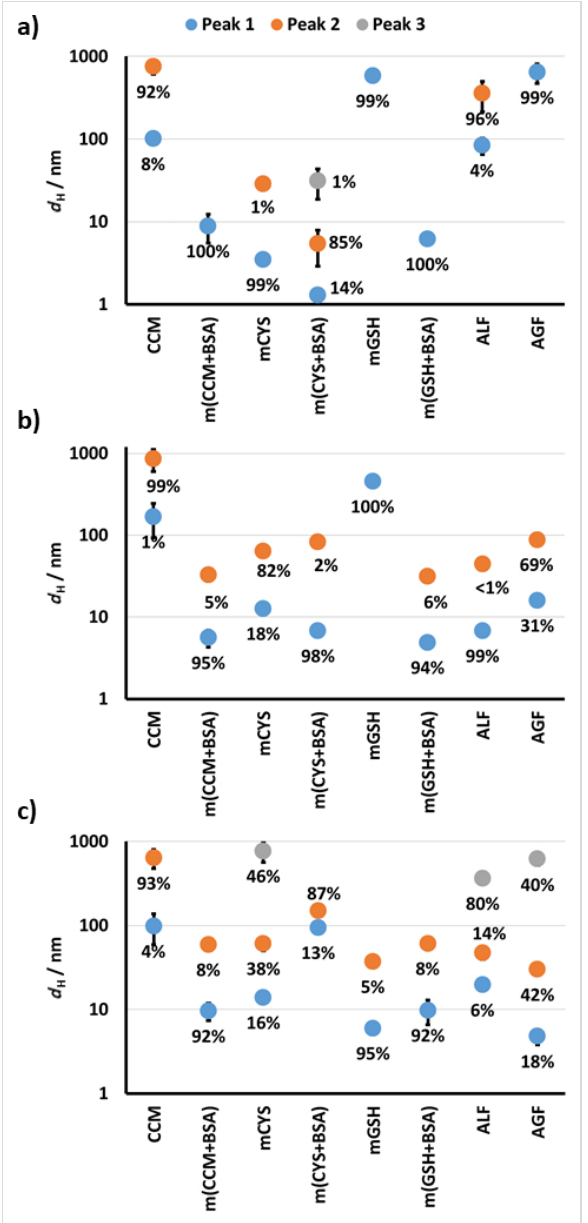
Figure 5: Changes in the hydrodynamic diameter ( d H ) of (a) AOT- AgNPs, (b) PVP-AgNPs, and (c) PLL-AgNPs in different biological media after 24 h of incubation. The media abbreviations are explained in Table 1. The existence of two or three peaks indicates a bimodal or trimodal size distribution, respectively, with the volume percentage given next to each point.